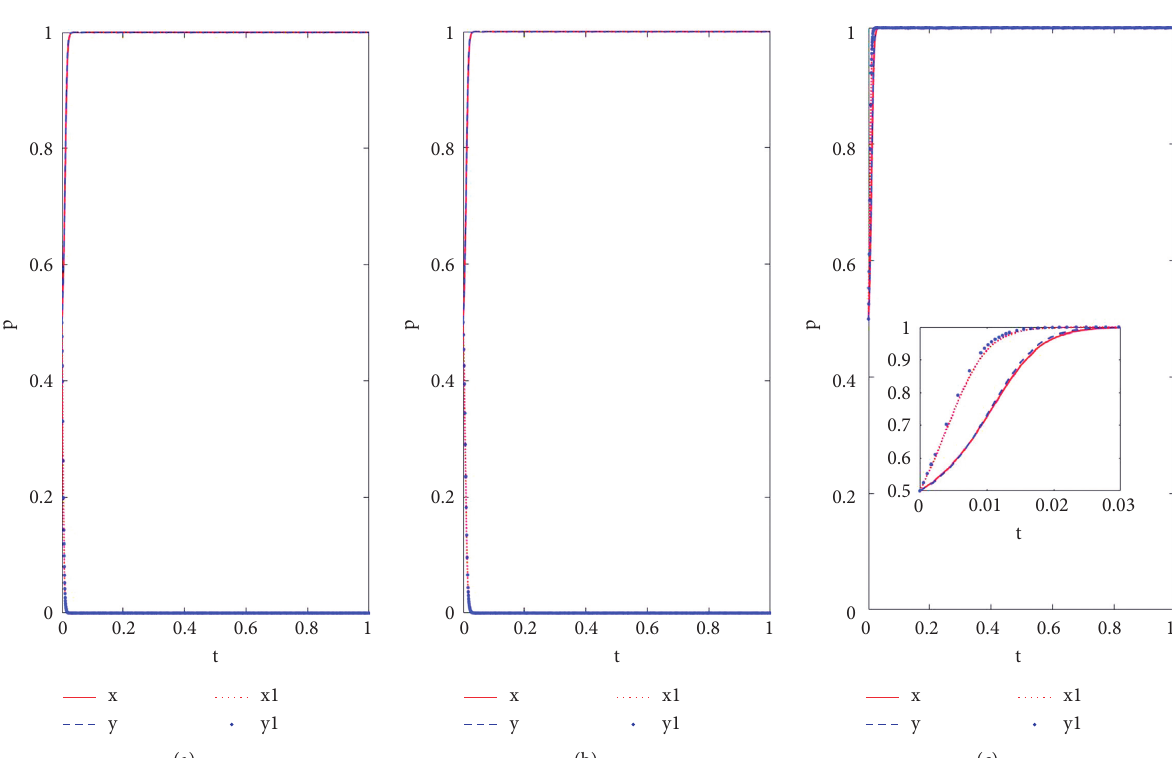
Figure 5: Influence of government participation on the evolution results of game